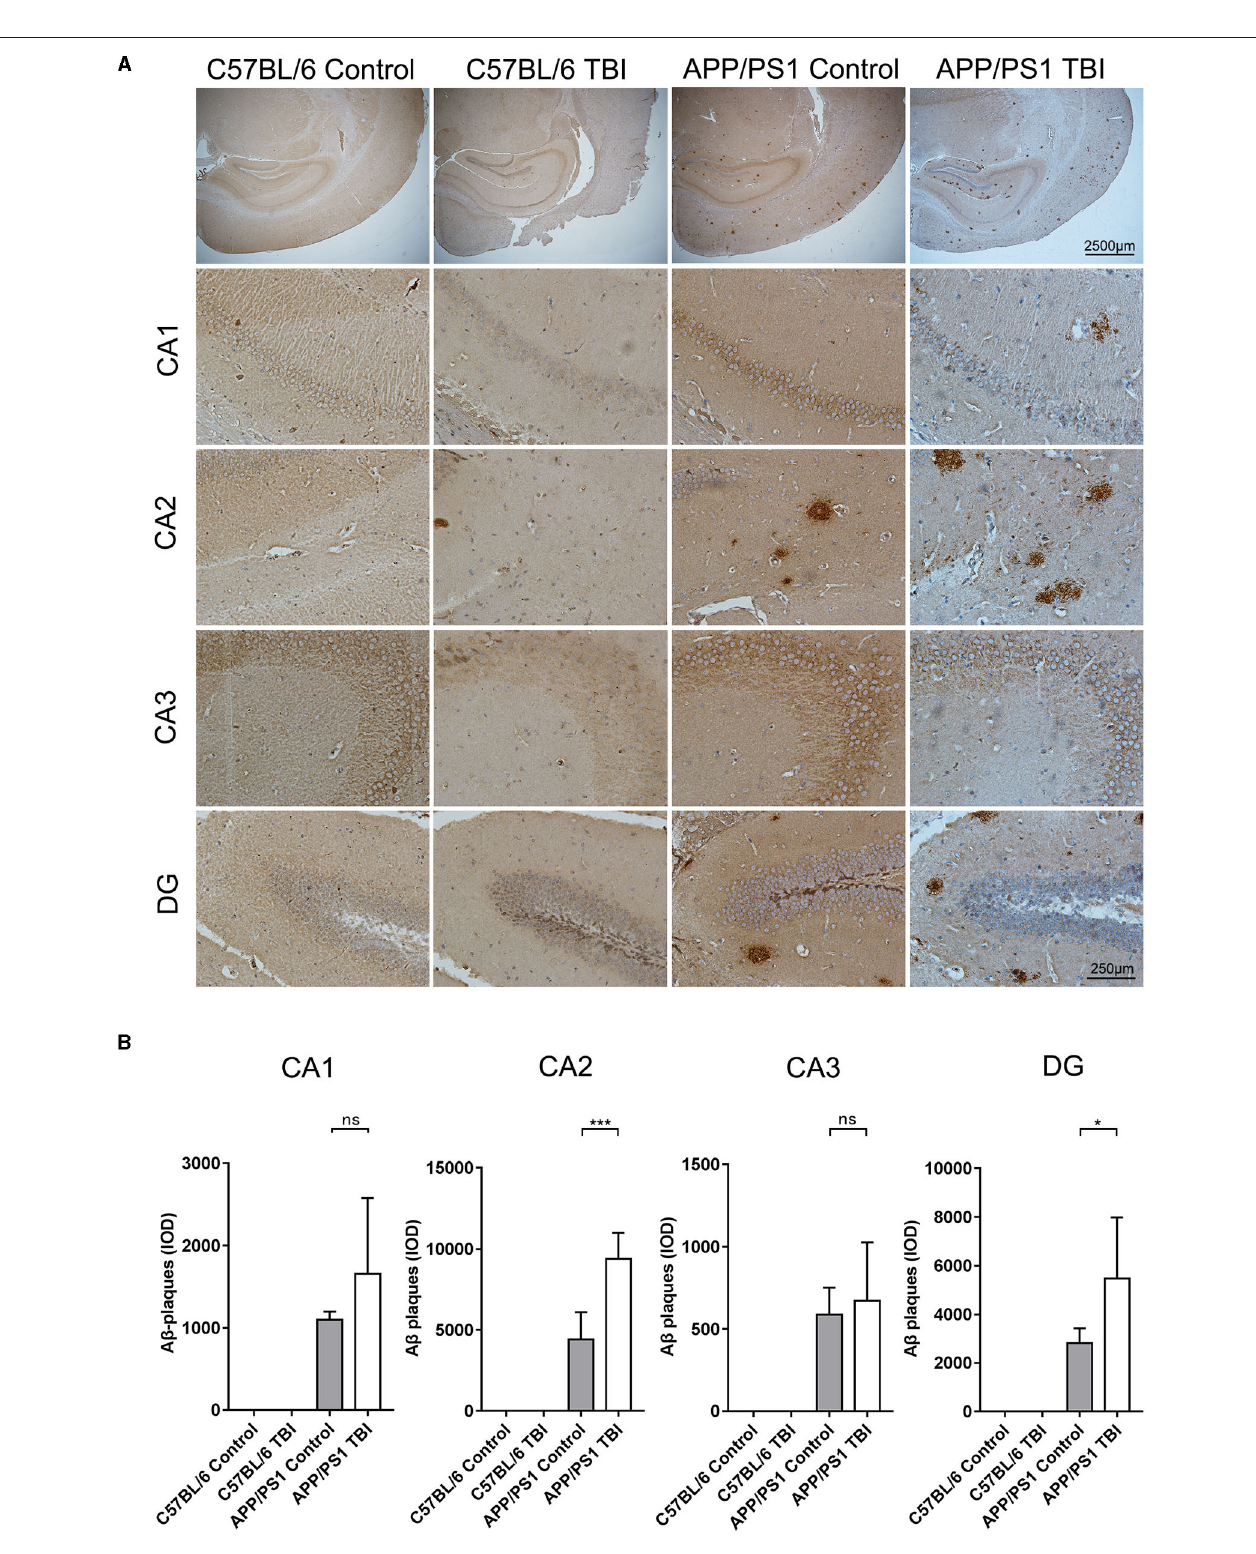
FIGURE 5 | TBI aggravated A β plaque deposition in the hippocampus in the APP/PS1 mouse model. (A) Representative IHC images of hippocampal (CA1, CA2, CA3, and DG) tissues from C57BL/6, C57BL/6 TBI, APP/PS1, and APP/PS1 TBI group mice immunostained for A β plaques. (B) Quantitative analyses of A β plaque deposition in the CA1, CA2, CA3, and DG regions of the hippocampus in C57BL/6, C57BL/6 TBI, APP/PS1, and APP/PS1 TBI mice. The error bars represent the SEM ( n = 8/group). ns, nonsignificant; * p < 0.05; *** p < 0.001.